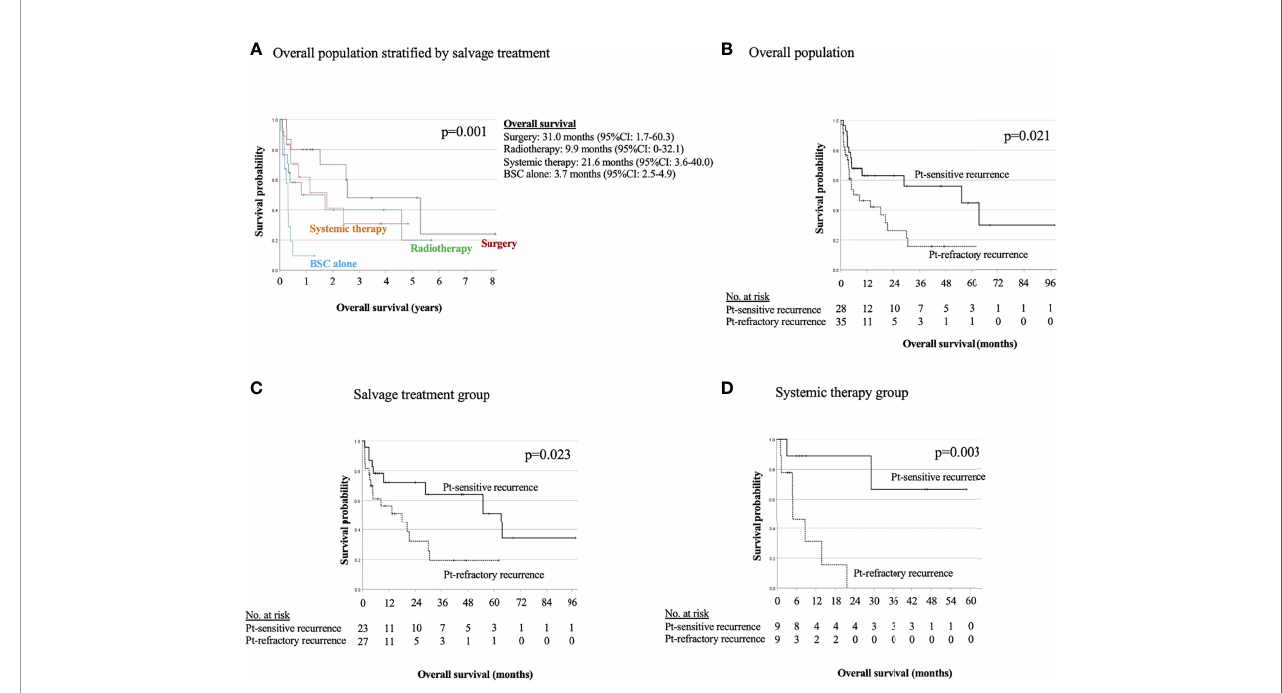
FIGURE 3 | Kaplan − Meier estimates of overall survival in overall population strati fi ed by salvage treatment (A) and in overall population (B) , salvage treatment group (C) , and systemic therapy group (D) strati fi ed between the platinum-refractory and platinum-sensitive